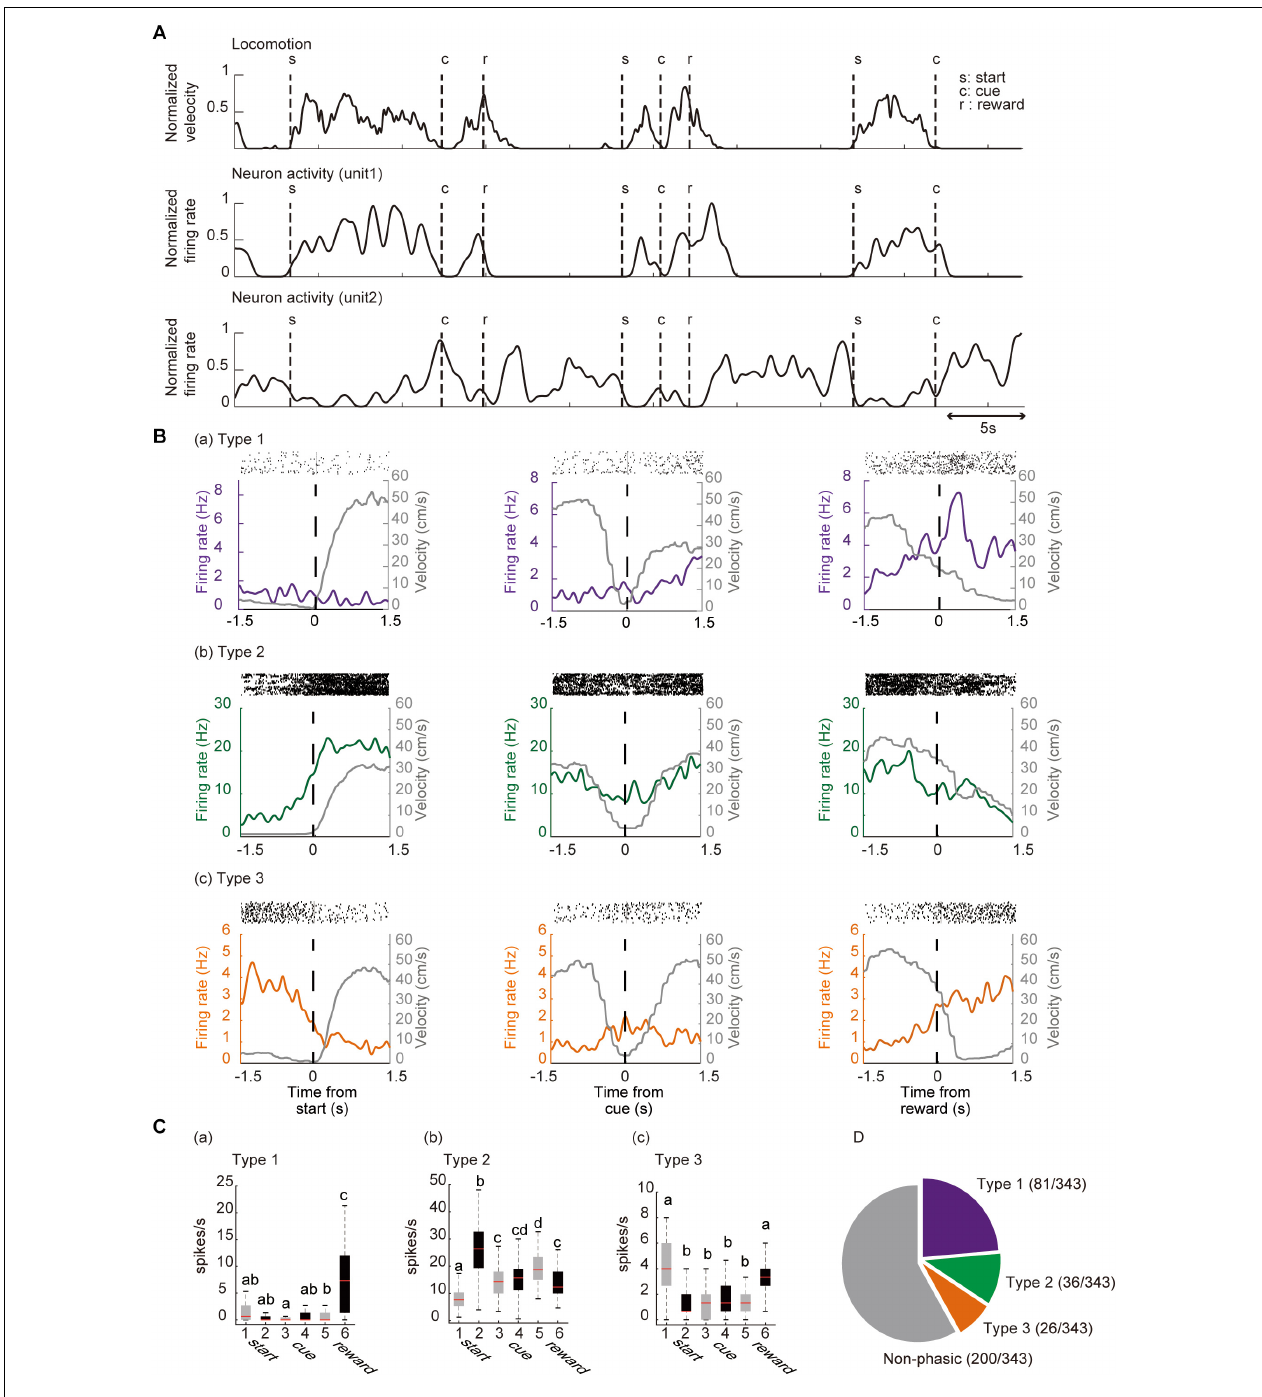
FIGURE 4 | Categorization of locomotor task-related neurons. (A) Representative traces of locomotion velocity (upper panel) and the simultaneous recordings of two ACC units (middle and lower panel) during the locomotor task. (B) Spiking activity in representative units, categorized based on their phasic activity as Type 1 (a), Type 2 (b), and Type 3 (c) neurons. Spike raster plots for 45–60 consecutive trials are shown in the top panel of each peri-event histogram (PETH). The lower panels show the averaged firing rate and the running velocity (gray), 1.5 s before and after each key task event. Vertical dashed lines in each graph indicate the time of the key task event. (C) Box plot of the firing rate 1.5 s before start (1), 1.5 s after start (2), 1.5 s before cue (3), 1.5 s after cue (4), 1.5 before reward (5), 1.5 after reward (6) of each neuron. Gray and black boxes indicate the mean firing rate before and after the event, respectively. Examples of a Type 1 (a), Type 2 (b), and Type 3 (c) neuron. Different lower-case letters on each bar indicate a significant difference, p < 0.05 (Bonferroni tests after one-way ANOVA) between each other. (D) Summary of the number of ACC neurons in each category. In box plots, the central mark indicates the median and the bottom and top edges of the box indicate the 25th and 75th percentiles, respectively. Whiskers extend to the most extreme data points not considered outliers.